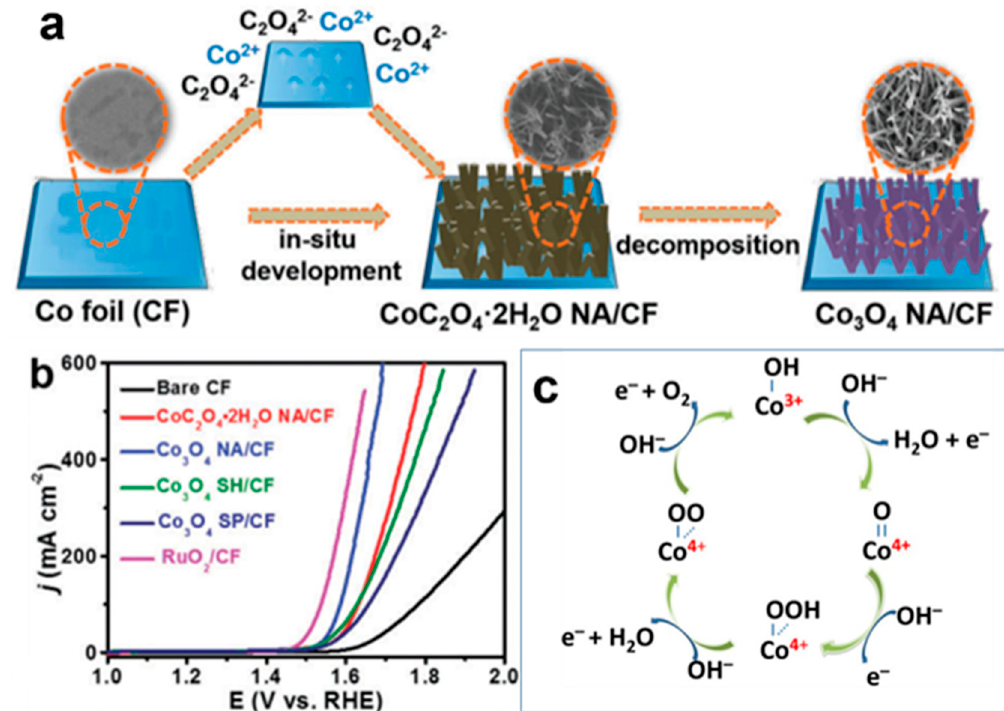
Figure 15. ( a ) Two-step manufacture of Co 3 O 4 NA/CF; ( b ) LSV curves (anodic sweep) of RuO 2 /CF, Co 3 O 4 NA/CF, CoC 2 O 4 ·2H 2 O NA/CF, and bare Co catalysts in O 2 -saturated 1 M KOH at 5 mV s − 1 at a